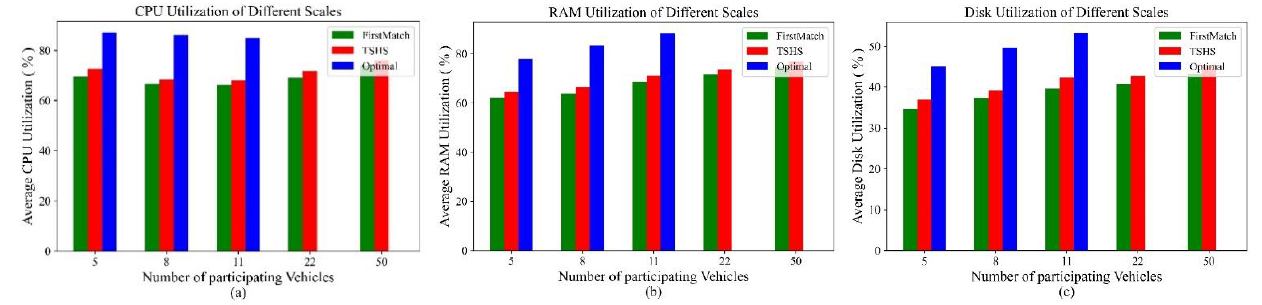
Figure 11. Utilization of different resources. ( a ) Utilization of CPU cores. ( b ) Utilization of RAM. ( c ) Utilization of disk.